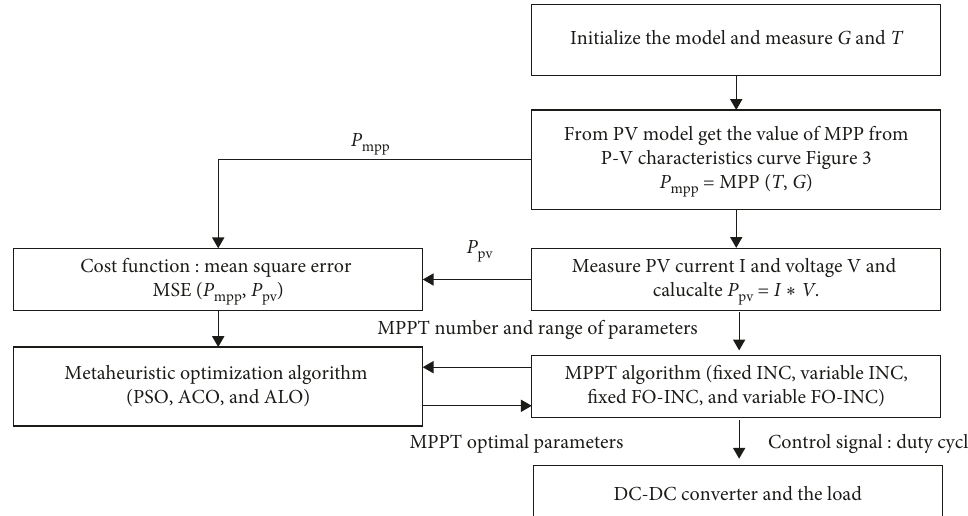
Figure 8: The proposed system implementation flowchart.